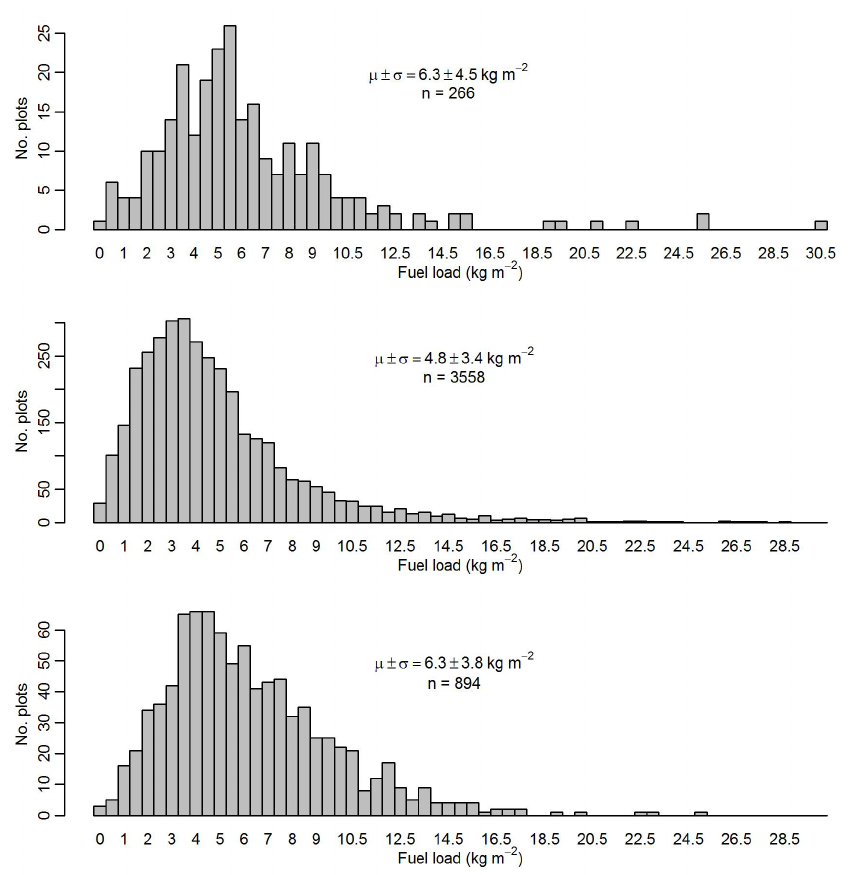
Figure 4. The distribution of surface fuel loading for the FIA plots of three FTGs: loblolly/shortleaf pine (160), Douglas fir (200), and California mixed conifer